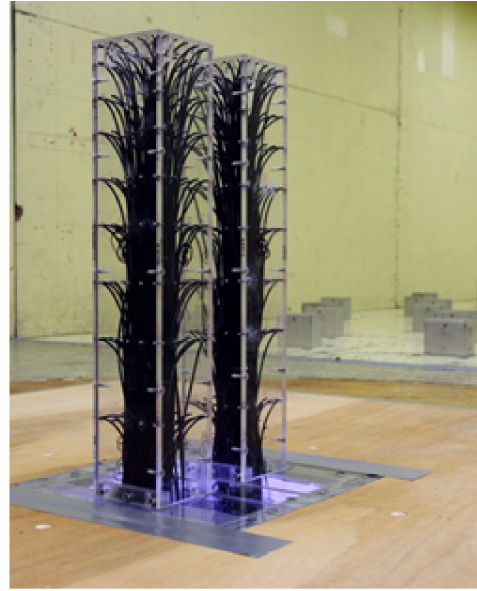
Figure 4. Two building models and equipment for measuring